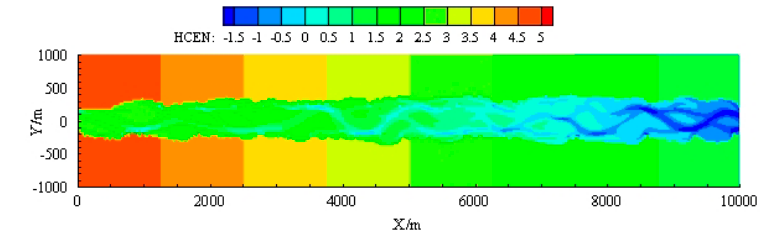
Figure 6. Layout of the conceptual channel after 720 days.